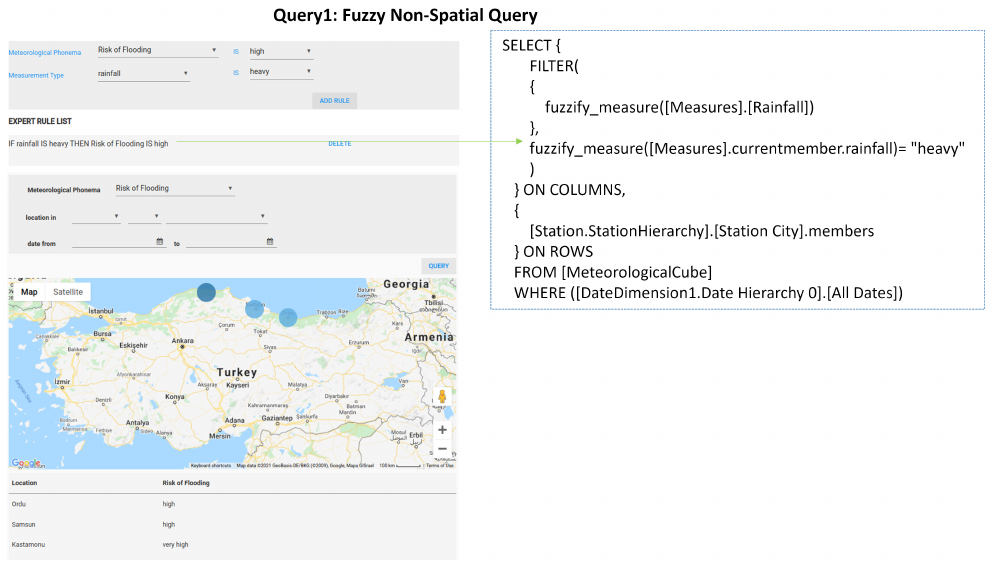
Figure 10. Fuzzy non-spatial